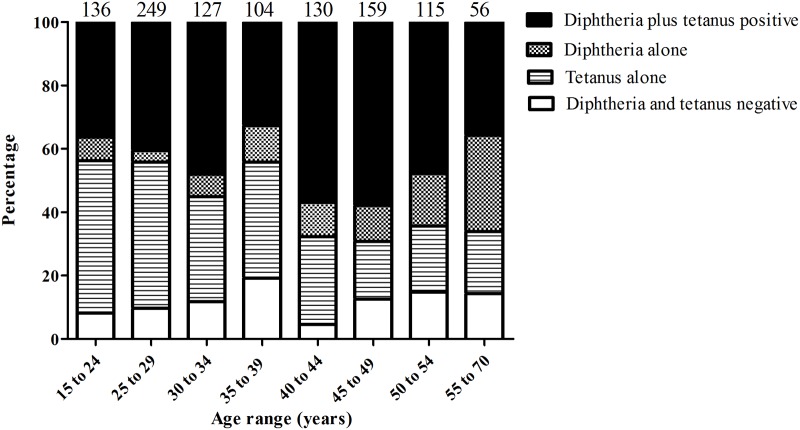
Tetanus and diphtheria antibodies according to age.Numbers above columns represent number per age group.